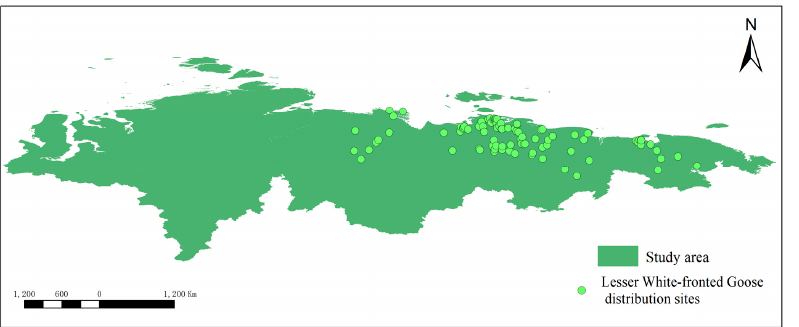
Figure 2. Distribution point data for lesser white-fronted goose obtained by satellite tracking and field verification in the study